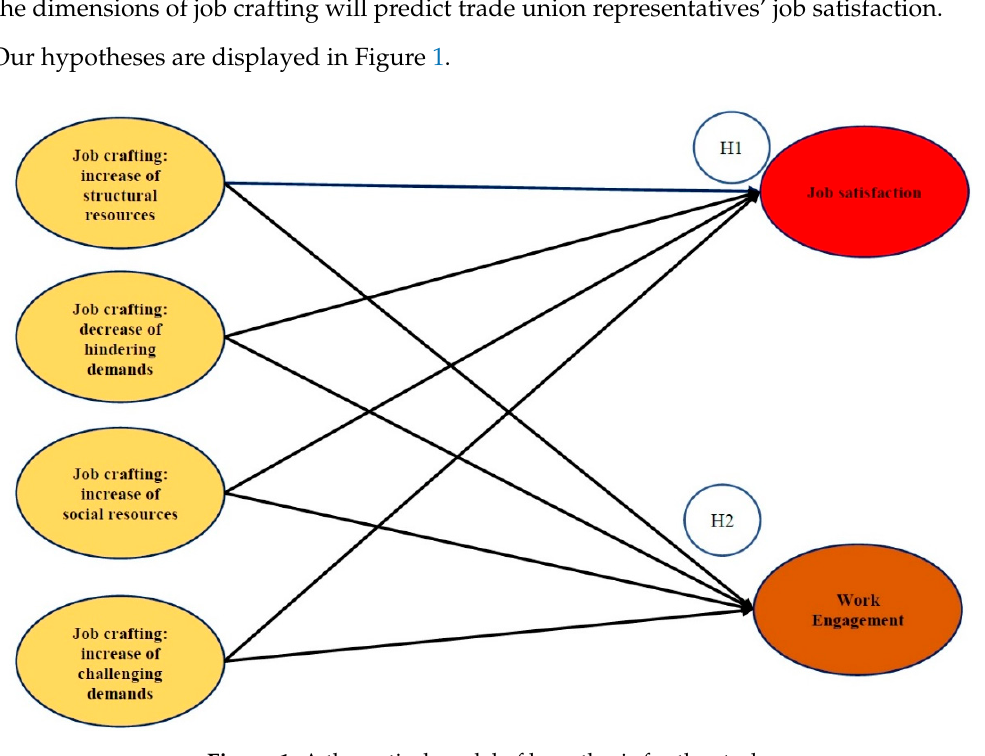
Figure 1. A theoretical model of hypothesis for the study.